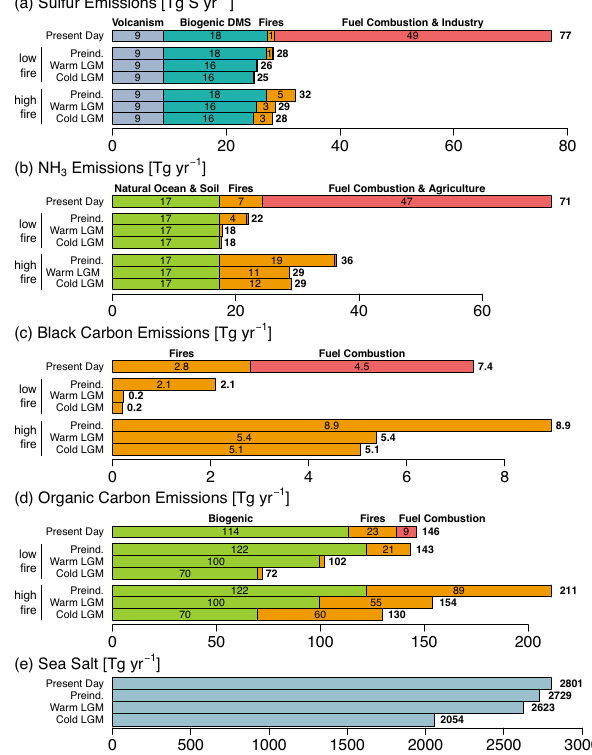
Fig.6. SameasFig.5,butaerosolprecursoremissions. Fig. 6. Same as Fig. 5 but for aerosol precursor emissions.